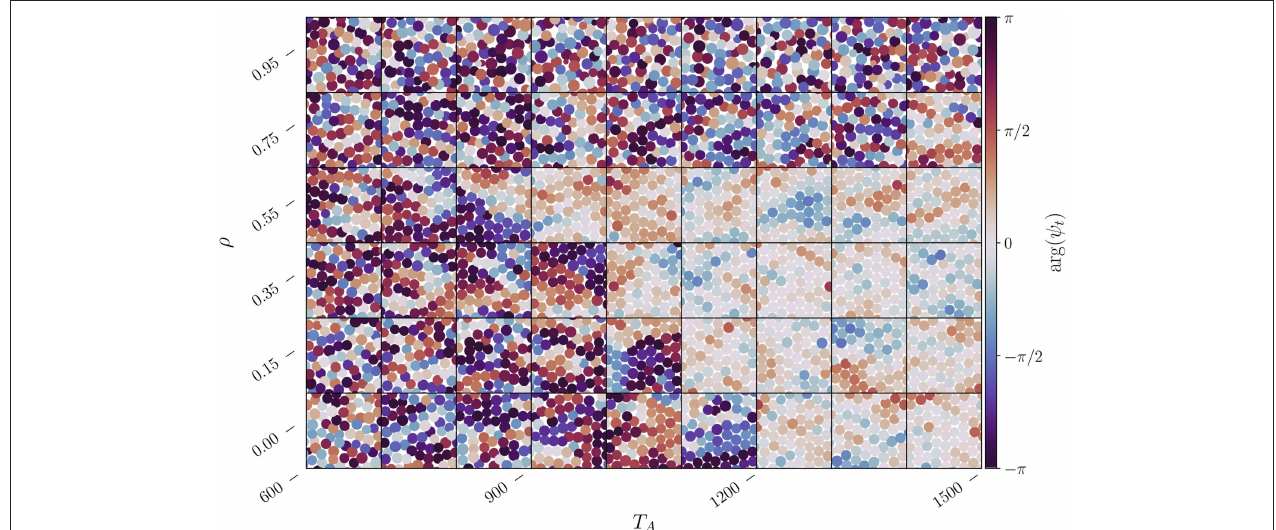
r ℓ as a function of ρ and T A for the system parameters utilized E